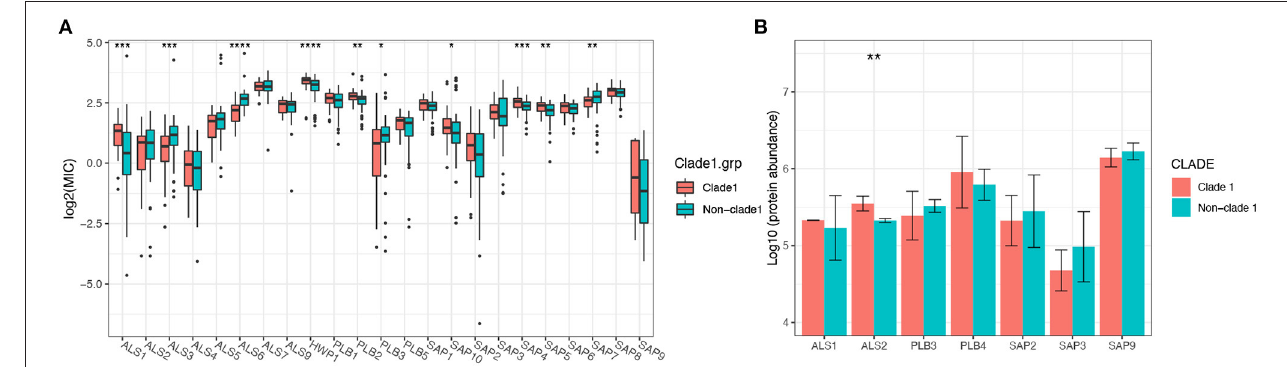
FIGURE 5 | The mRNA expression levels of the virulence genes of C. albicans isolates varied significantly between MLST clade 1 and non-clade 1, while only ALS2 presented a significantly higher protein expression level. In total, 10 out of 23 genes from four virulence families, including SAP, HWP, PLB, and ALS, showed significantly different mRNA expression levels between clade 1 and non-clade 1 (A) . However, only seven proteins from these four virulence gene families were detected by proteomic analysis (B) , and ALS2 showed a significant difference between clade 1 and non-clade 1. * p < 0.05. ** p < 0.01. *** p < 0.001. **** p <